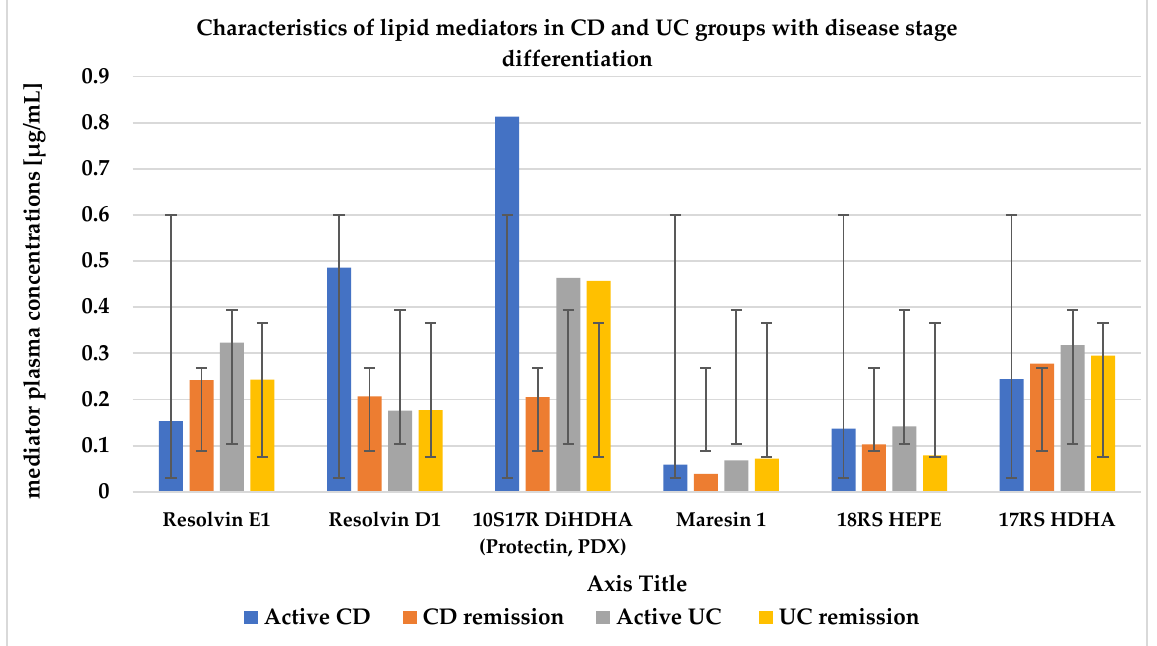
Figure 5. Characteristics of lipid mediators in CD and UC groups with disease stage differentiation. CD —Crohn’s disease, UC— ulcerative colitis.